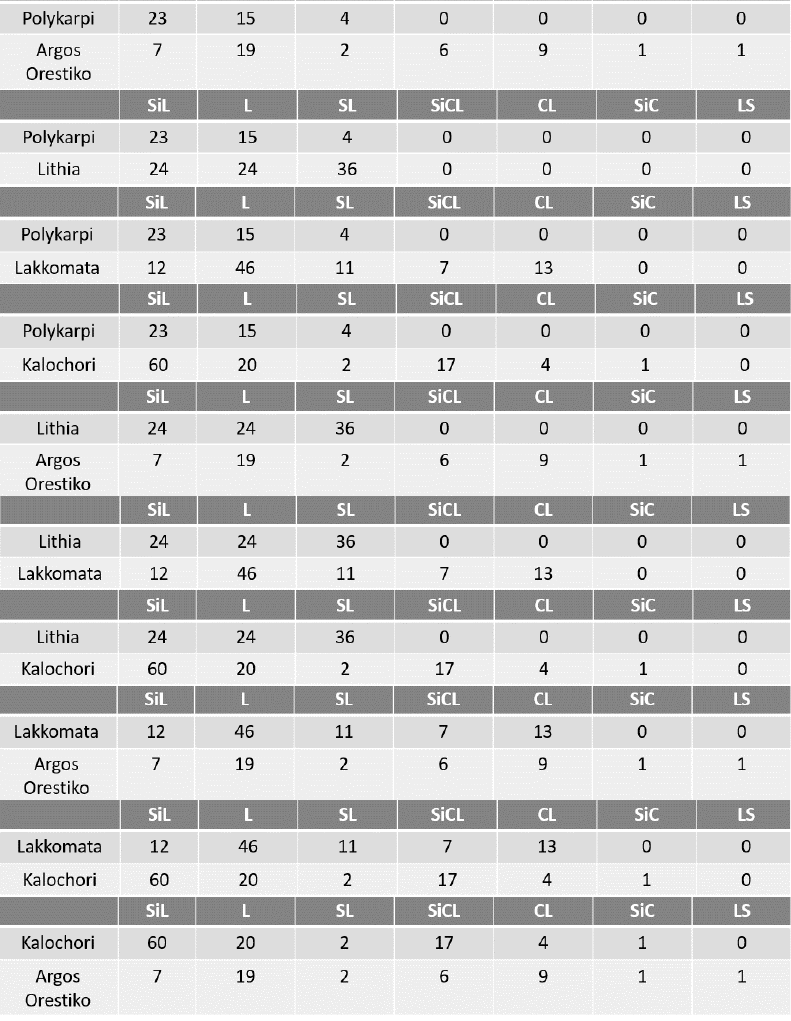
Figure A1. Contingency tables of Kastoria Table 2. p-values of Freeman-Halton exact test based on the above contingency tables